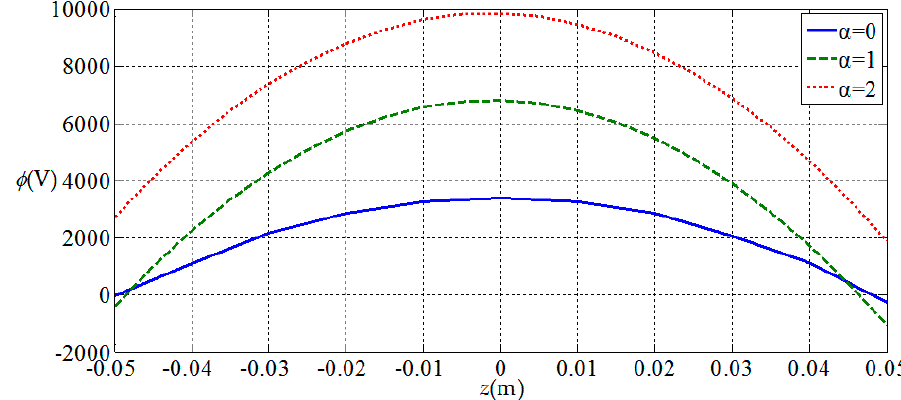
Figure 9. Variation of electric potential at the periphery of plate φ ( 1, z ) with coordinates z